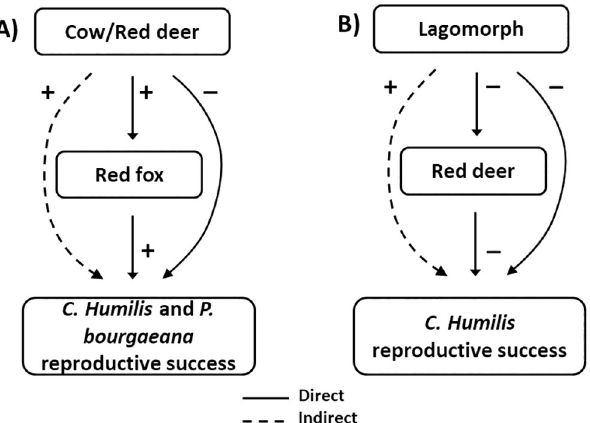
Fig 7. Effects on C . humilis and P . bourgaeana ’s reproductive success. Direct and indirect interaction pathways between pairs of frugivore species in relation to Chamaerops humilis and Pyrus bourgaeana ’s reproductive success based on interaction patterns obtained from null models 2 and